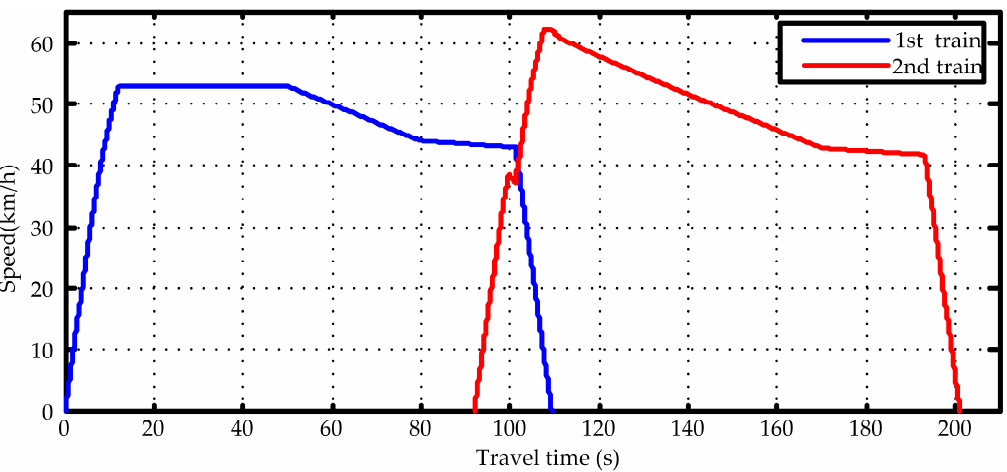
Figure 4. Optimal energy-saving operation curve of two trains.